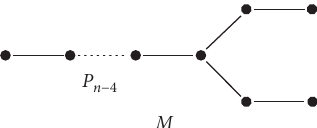
Figure 8: The tree M .